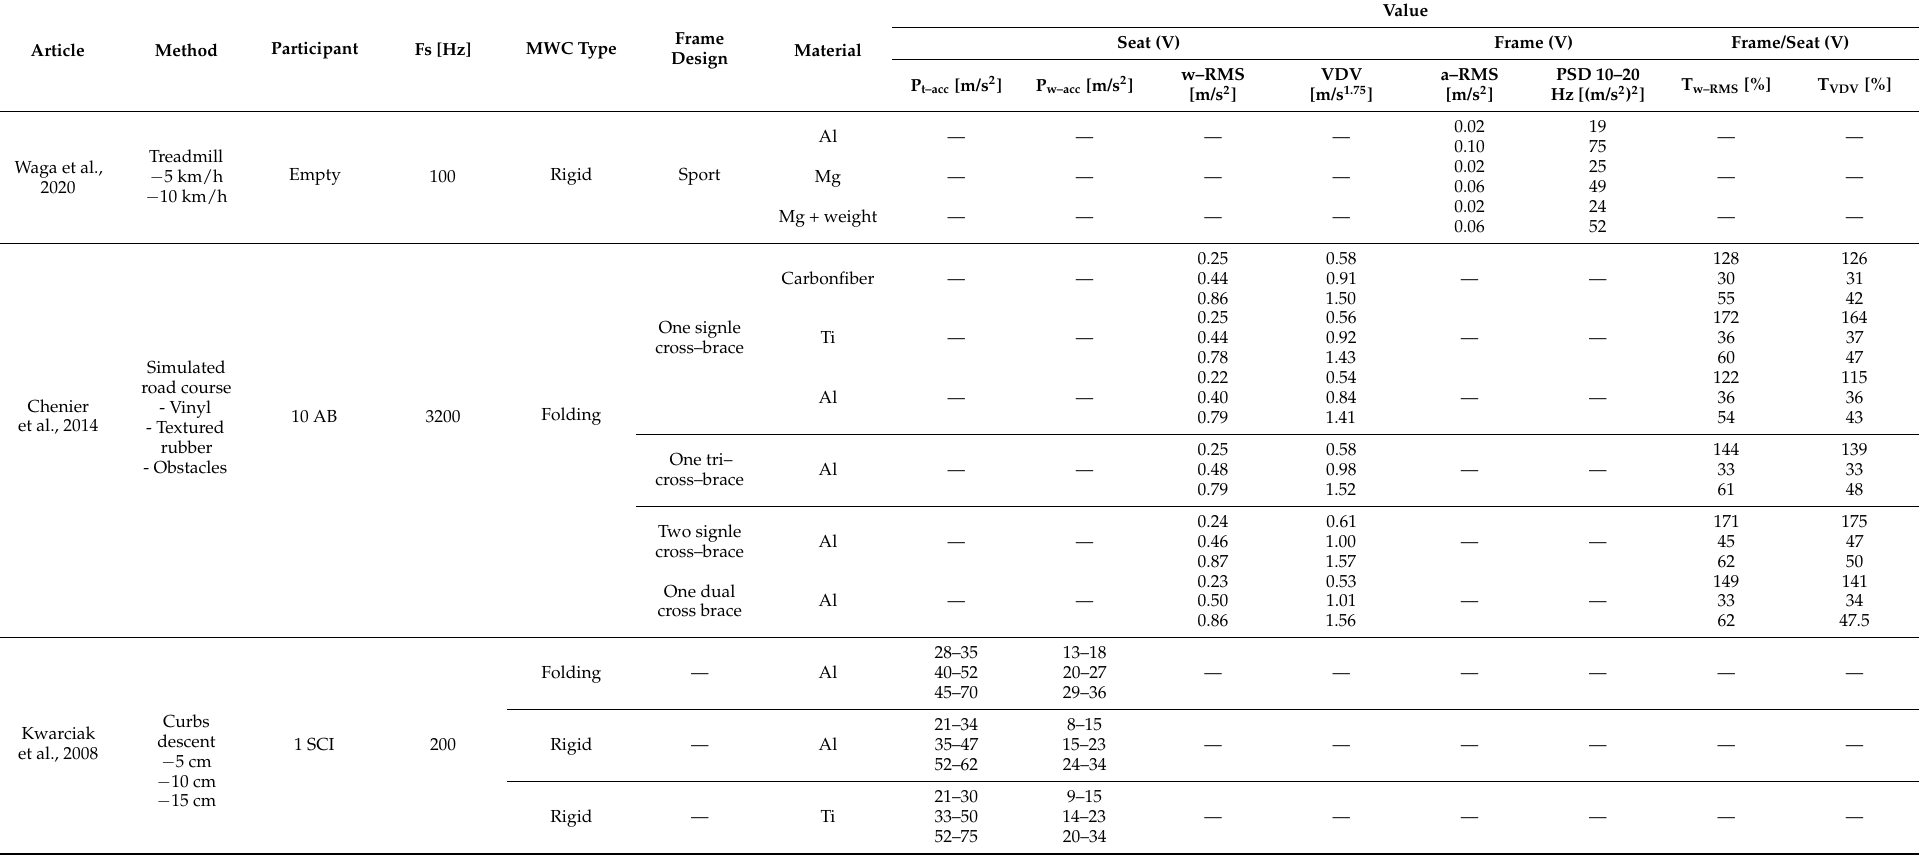
Table 7. Summary table of reviewed studies regarding the effect of the frame on the vibration